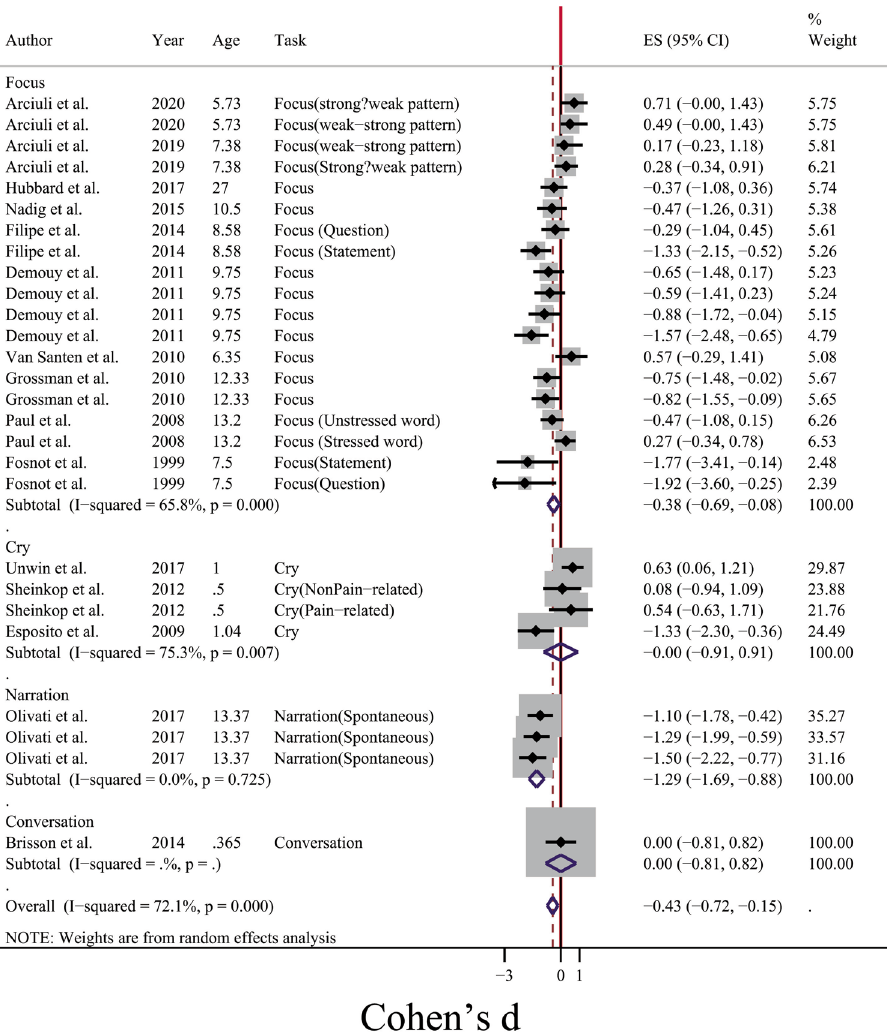
Figure 3. Forest plot for the subgroup meta-analysis of the difference of voice duration between ASD and TD groups. The confounding factor for this analysis was the type of voice elicitation